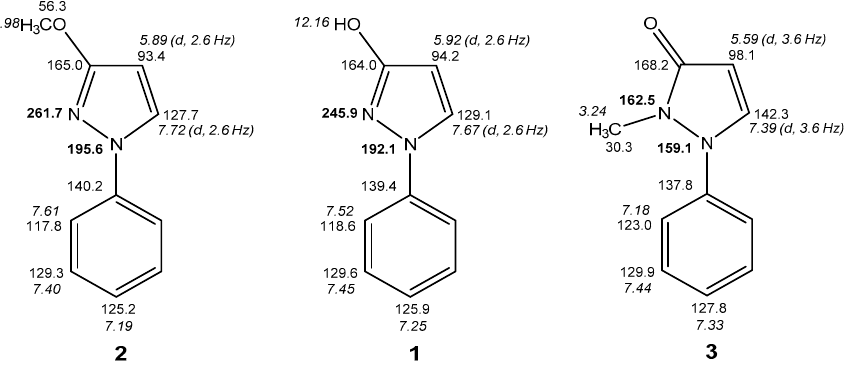
Figure 5. 1 H-NMR (in italics), 13 C-NMR, and 15 N-NMR (in bold) chemical shifts of 1 and its “fixed” derivatives 2 and 3 (in CDCl 3 ).